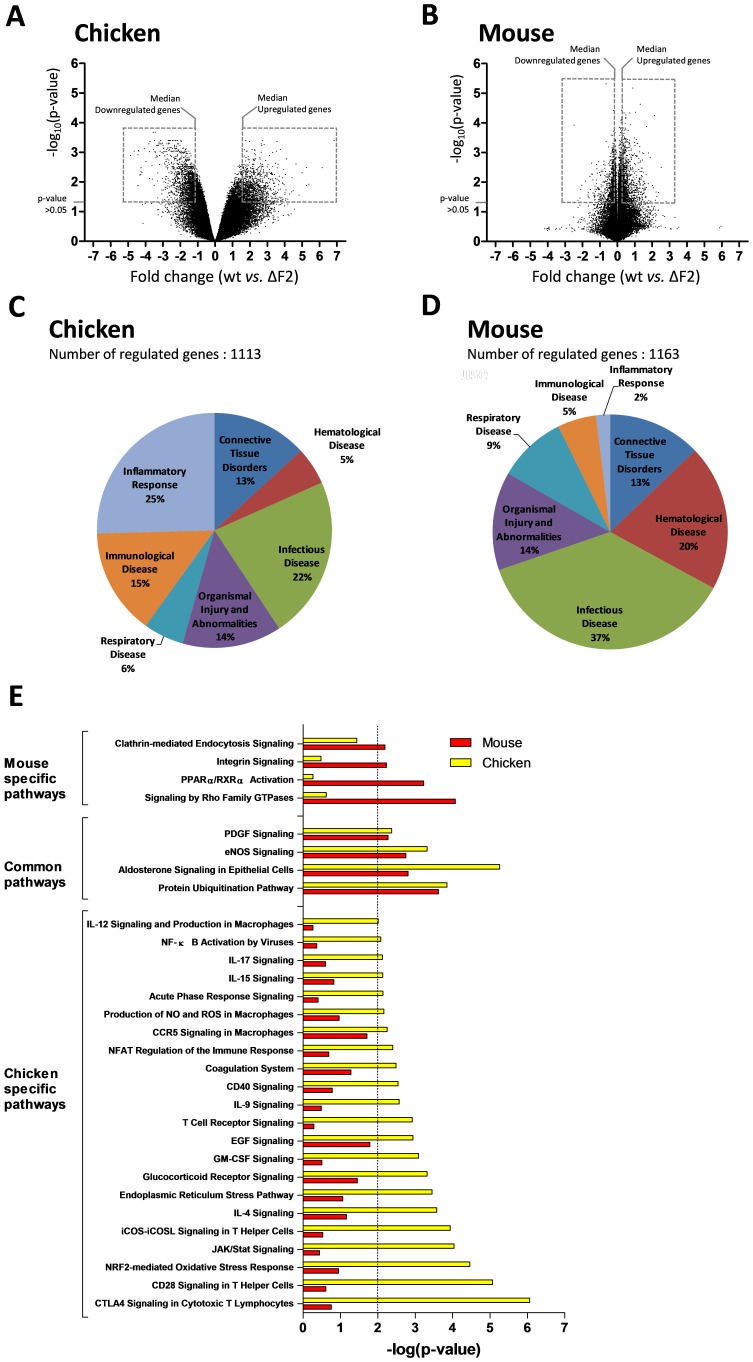
Comparison of Nig06 PB1-F2 impact on the lung host-response in chicken and mouse.(A) Scatter plot comparing wt-infected chickens vs. ΔF2-infected chicken lung transcriptomes at day 2 pi. Genes selected for ontological analysis are highlighted. (B) Scatterplot comparing wt-infected mice vs. ΔF2-infected mice lung transcriptomes at day 2 pi. (C) Distribution of major GO functions associated to genes regulated by PB1-F2 in infected chicken lungs. (D) Distribution of major GO functions associated to genes regulated by PB1-F2 in infected mouse lungs. (E) Canonical pathways associated to differentially expressed genes in chicken and mouse were compared using Ingenuity Pathways Analysis and ranked with the p-value obtained using the right-tailed Fisher's exact test.